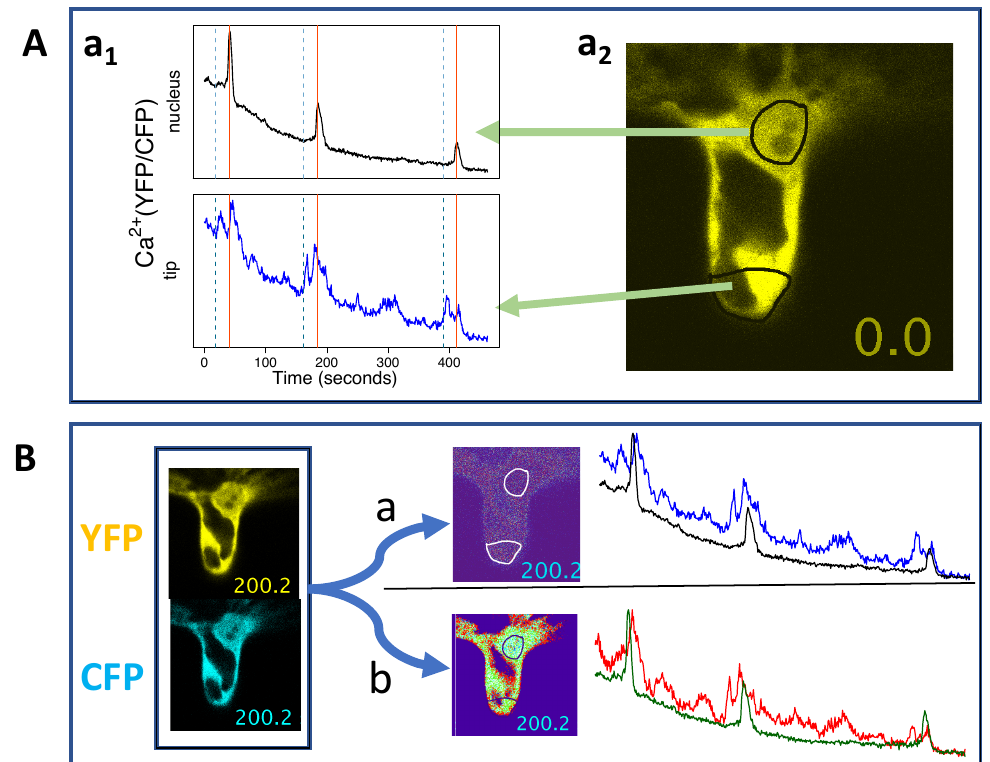
Figure 6. Apparent apical and nuclear Ca 2 + spikes are related in a complicated way. Panel ( A ), a 1 , shows oscillations in perinuclear and apical YFP/CFP ratios, corresponding to the statically-defined regions of interest observed in the image of the root hair YFP signal ( a 2 ), where the black region corresponds to the sensor-free vacuole. Panel ( B ) shows the impact of imaging processing on ratio images ( t = 200.2 s) and on the YFP/CFP time series. Option a , Panel (B), corresponds to the use of the RatioPlus [61] plugin without background subtraction and without previous filtering of the YFP and CFP images. Option b , Panel (B), corresponds to the application of a two-pixel median filter on the YFP and CFP images, followed by the use of RatioPlus with background subtraction and clipping. The time series of Option a , Panel (B), are exactly the same (and corresponding to the same times), as those shown in Panel (A), a 1 , with the ratio YFP/CFP at the nucleus in black, superimposed on the ratio at the tip, in blue. The time series corresponding to Option b , Panel (B), show the ratio YFP/CFP at the tip in red and the ratio at the nucleus in dark-green. Data were recorded every 0.79 s, and the Ca 2 + sensor was the cytosolic/nuclear-localised YC3.6. Note that although the times at the first and last pixels in an image frame are not exactly the same (because of line scanning), the relation between nuclear and apical traces is not significantly affected by the scanning starting position: if we shift the tip traces by one time point, we do not see any significant